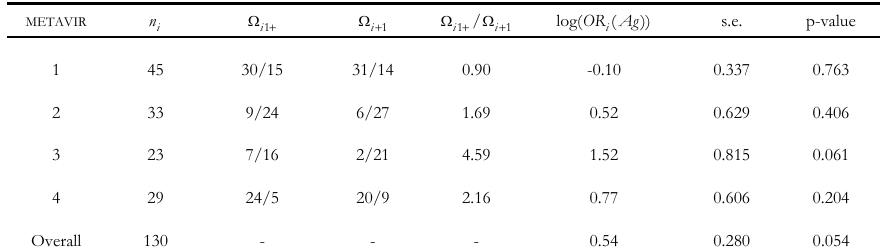
Agreement assessment: odds, odds ratios, log-odds ratios, standard errors and p-values METAVIR